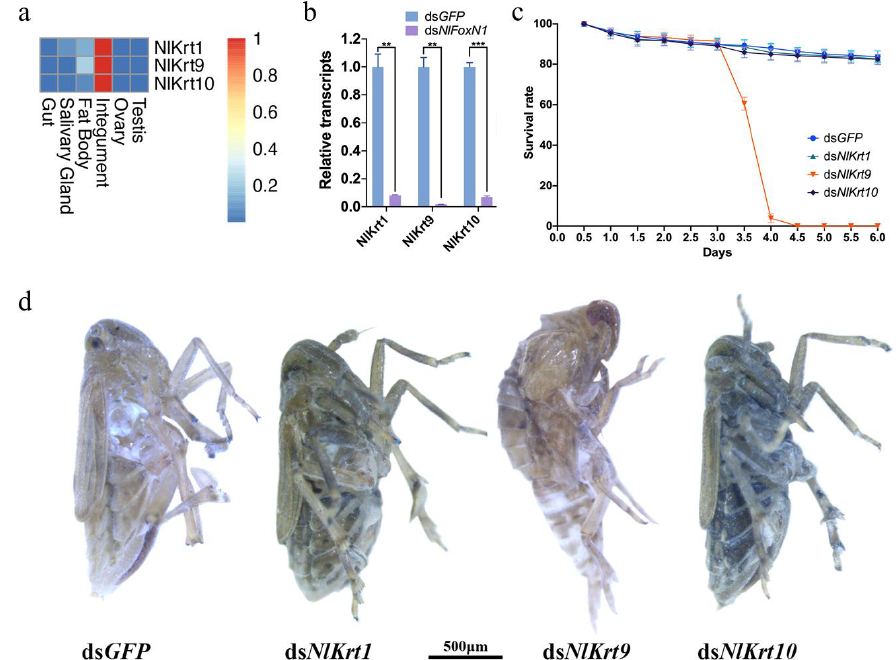
Figure 5. The GO enrichment analysis of the DEGs in nymphs. The GO enrichment study was performed using OmicShare tools. MF: molecular function, CC: cellular component, bp: biological process.